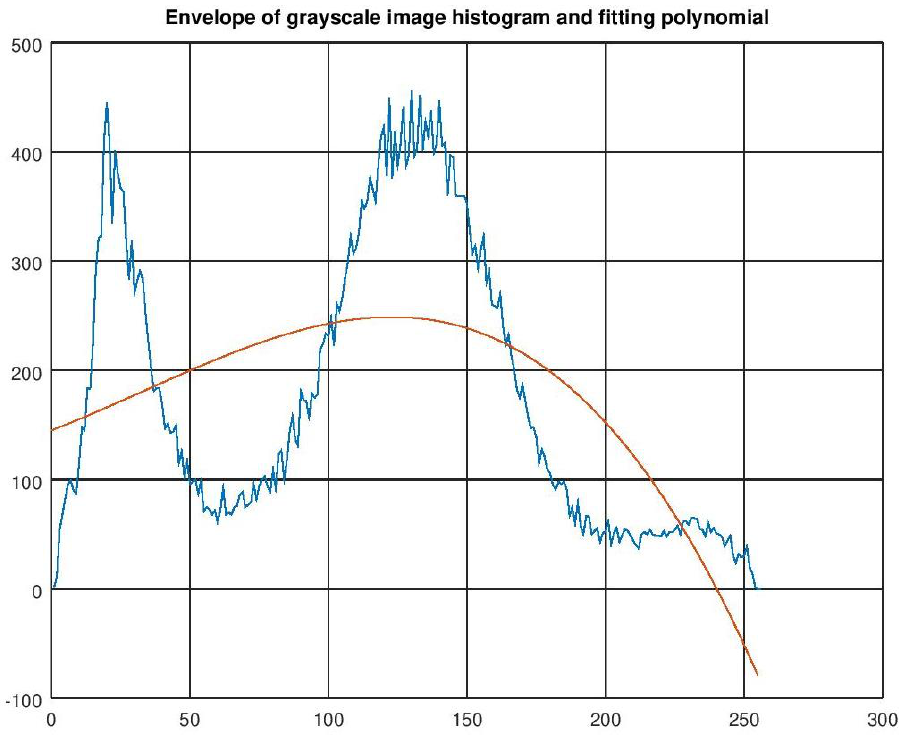
Figure 26. Failure of threshold calculation due to poor fitting. A different problem occurs when a low degree polynomial produces a threshold very close to the end of the histogram (x = 255), which results in poor contour extraction. Such a case is demonstrated in Figure 27 for test image shipwreck world with n = 5.